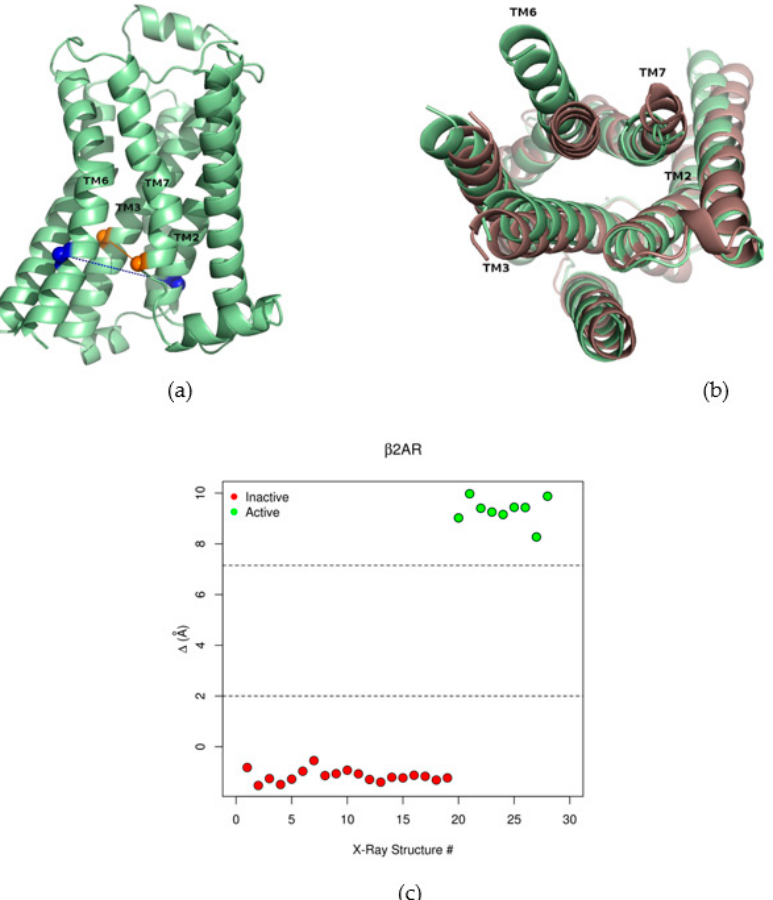
Figure 2. The collective variable ∆ . ( a ) Active conformation of the β 2AR, showing the residues involved in the definition of Δ . The C α′ s of residues Y70 and G276 are represented by blue spheres and the distance between them (d1) is indicated by blue dots. The C α′ s of residues C125 and I325 are shown as orange spheres and the distance between them (d2) is indicated by orange dots. Δ = d1 − d2; ( b ) Superposition between inactive (red) and active (green) conformations of β 2AR, showing the outward movement of TM6 and the inward movements of TM7 and (to a lesser extent) TM3, that increase ∆ upon activation. ( c ) Values of ∆ for inactive (red) and active (green) experimental structures of β 2AR. The order of structures coincides with Table S1.